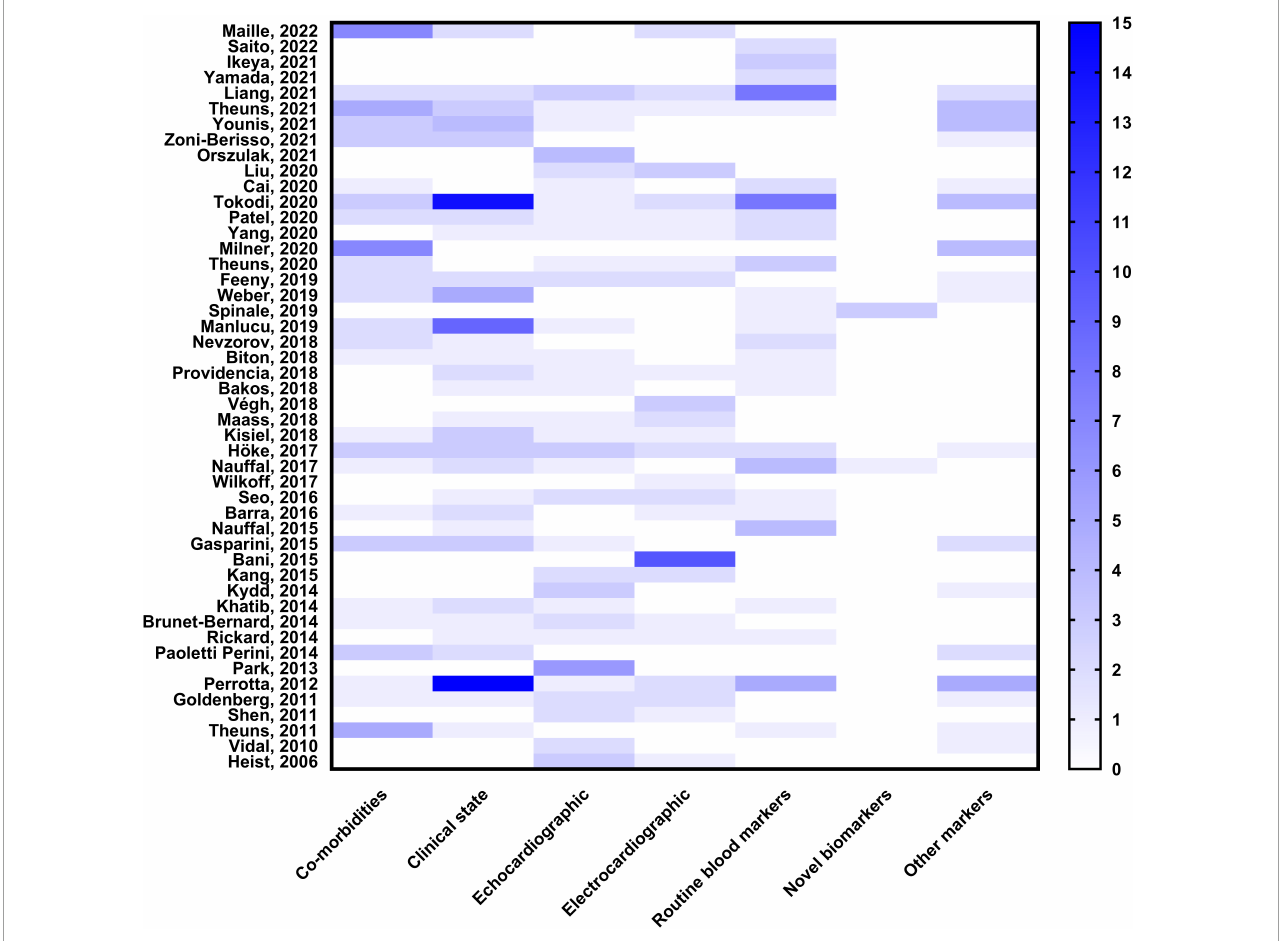
FIGURE2 Heat map of the predictors used in the risk scores of cardiac resynchronization